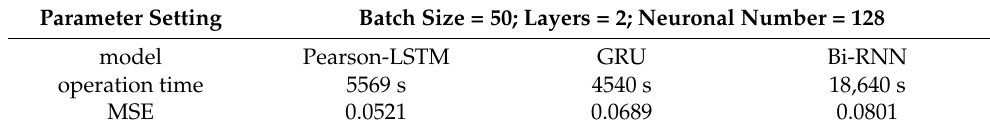
Table 4. Comparison of operation results.